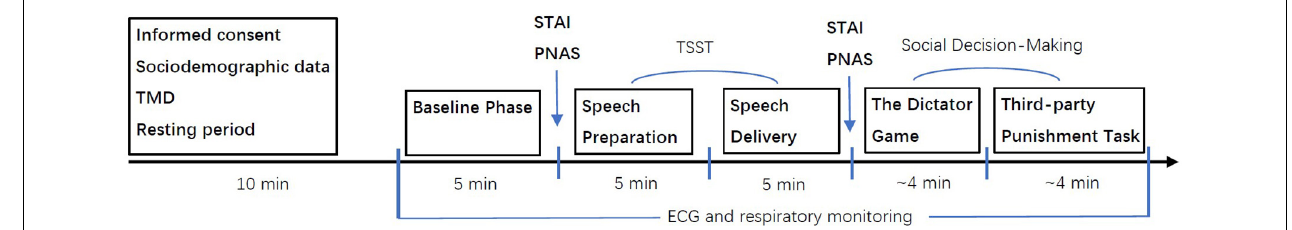
FIGURE 1 | Flow chart of the experiment procedure. TMD, triple dominance measure; STAI, State-Trait Anxiety Inventory; PANAS, positive and negative affect schedule; TSST, Trier Social Stress